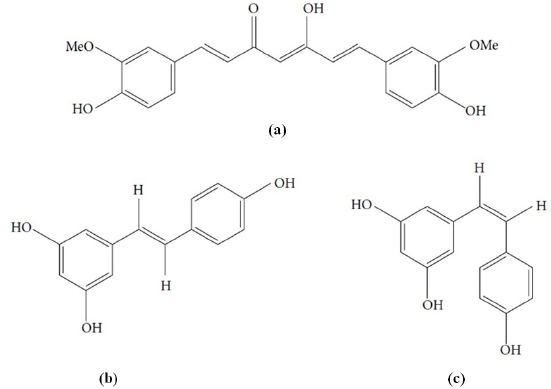
Figure 1. Chemical structures of ( a ) curcumin, ( b ) trans -resveratrol and ( c ) cis -resveratrol.